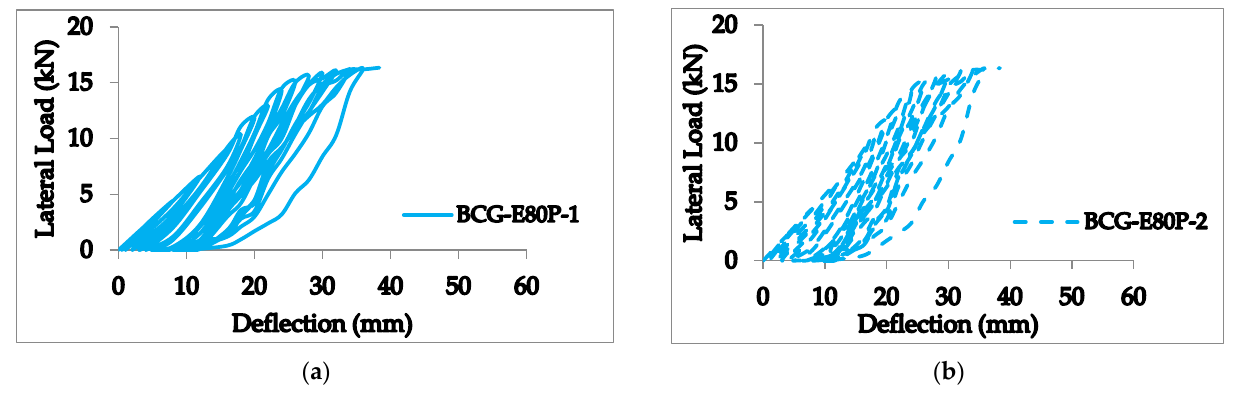
Figure 12. The hysteretic curve of the GFRP-ECC80P beam-column. ( a ) Specimen 1; ( b ) specimen 2.